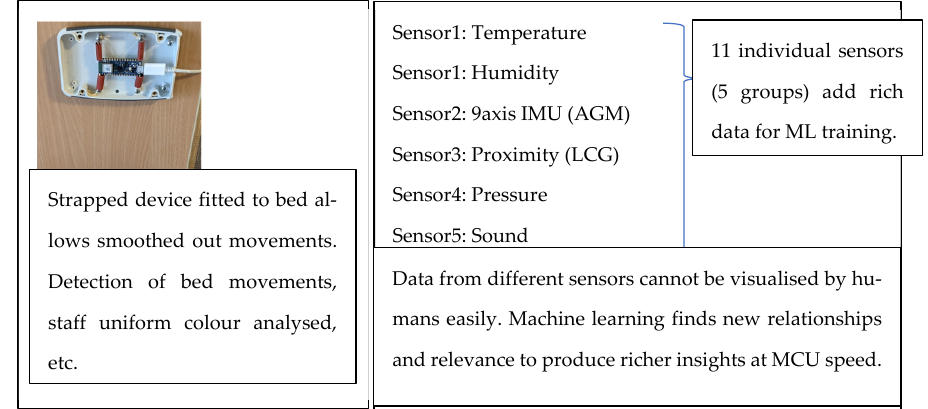
Figure 11. Example of an installed multisensor microcontroller device.